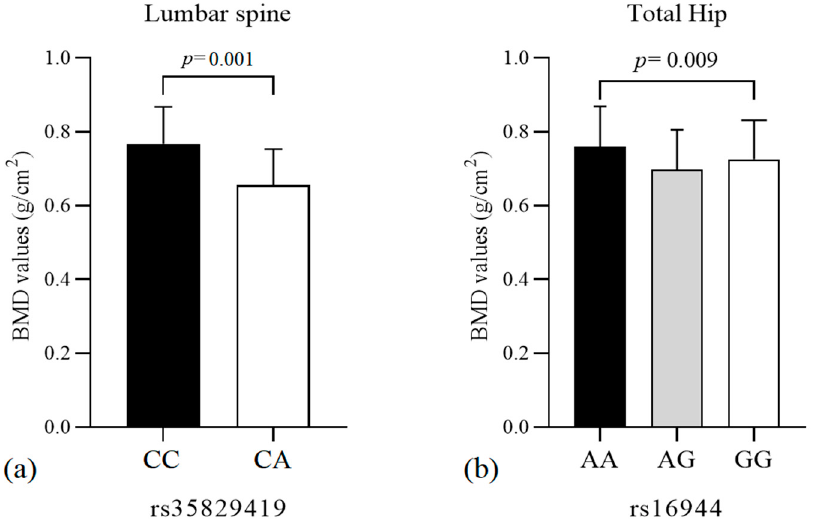
Figure 1. Comparison of bone mineral density stratified according to the genotypes of single-nucleotide variants rs35829419 of NLRP3 and rs16944 of IL-1 β gene. ( a ) Comparison of bone mineral density of lumbar spine area between genotypes of rs35829419 of NLRP3. ( b ) Comparison of bone mineral density in the total hip between genotypes of rs16944 of the IL-1 β gene. Statistical tests: ( a ) p -value student’s T = 0.001. ( b ) p -value ANOVA = 0.012; p Tukey post hoc test = 0.009 (AA vs. GG genotype).